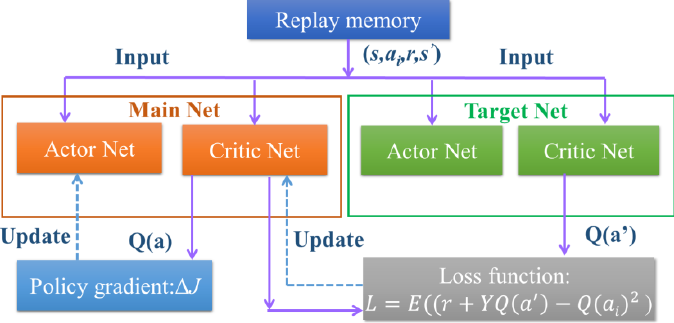
Figure 6. DPG algorithm framework.